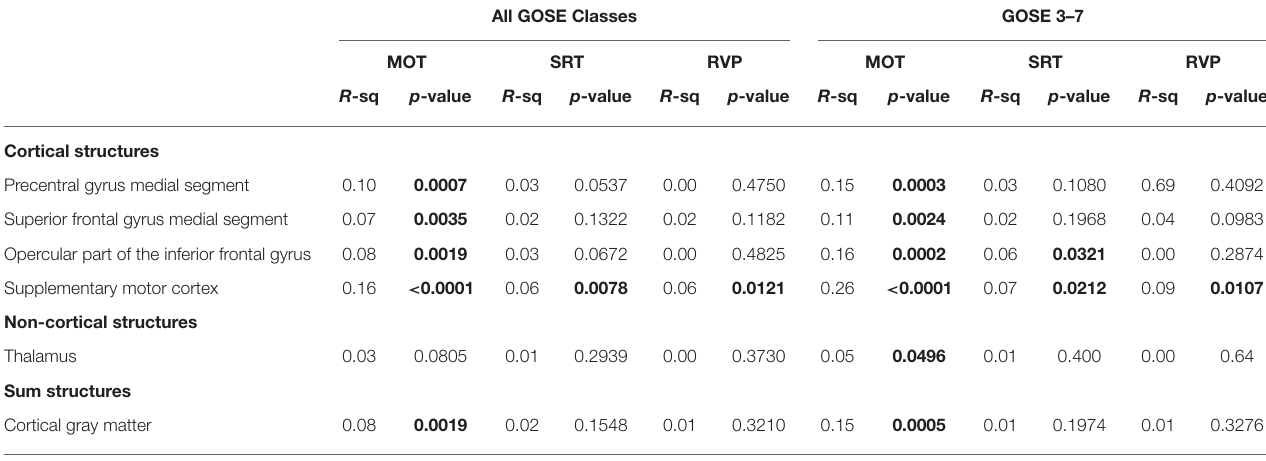
TABLE 5 | Relationship between atrophy rate and CANTAB results by linear